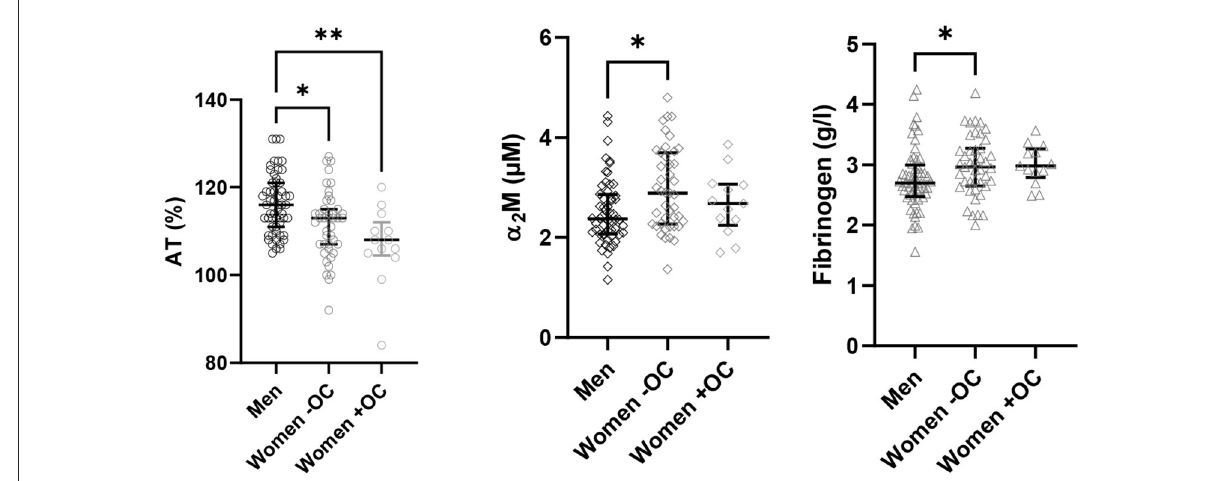
FIGURE3 Antithrombin, α 2 M and fibrinogen levels. The coagulation factor levels were measured in the plasma of 112 healthy donors and are depicted for the three groups: men, women without OC and women with OC. Data are median with IQR. AT, antithrombin; OC, oral contraceptives. * P ≤ 0.05, ** P ≤